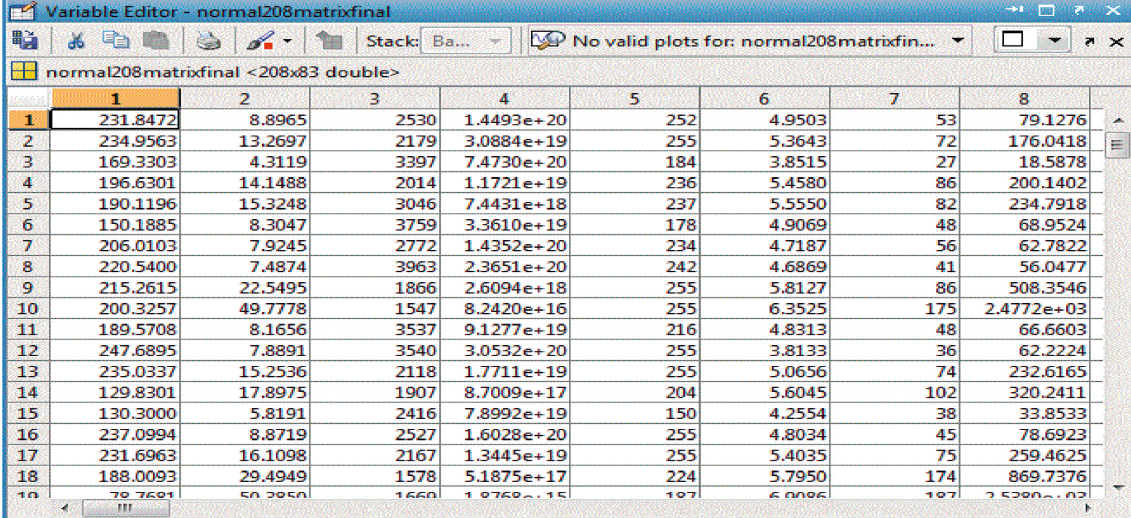
Figure 9: A snapshot of a portion of statistical